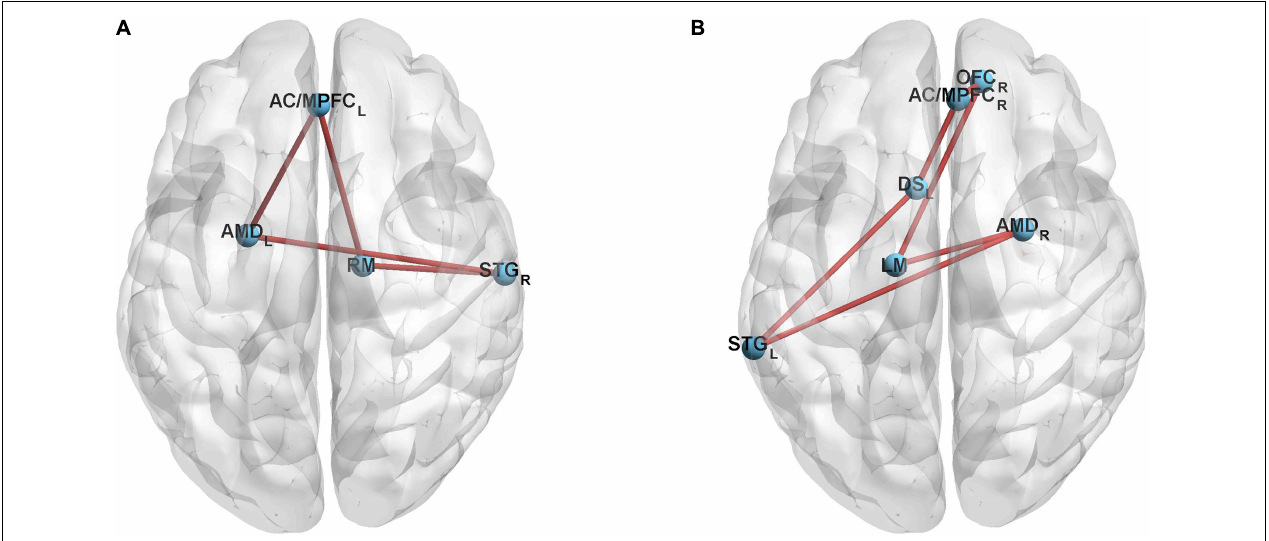
FIGURE 4 | Comparison of the connections between the superior temporal gyrus and the reward system of musicians when musicians listen to music with familiar and unfamiliar styles. (A) Music with Chinese style: Chinese-trained vs. Western-trained musicians. Stronger connections concluded edges among the right superior temporal gyrus, right midbrain, left amygdala, and left medial prefrontal cortex. (B) Music with Western style: Western-trained vs. Chinese-trained musicians. Stronger connections concluded edges among the left superior temporal gyrus, left midbrain, right amygdala, right medial prefrontal cortex, left dorsal striatum and right orbitofrontal cortex. The red lines represent the enhanced connections. The statistical results are presented in Tables 3 , 4 .